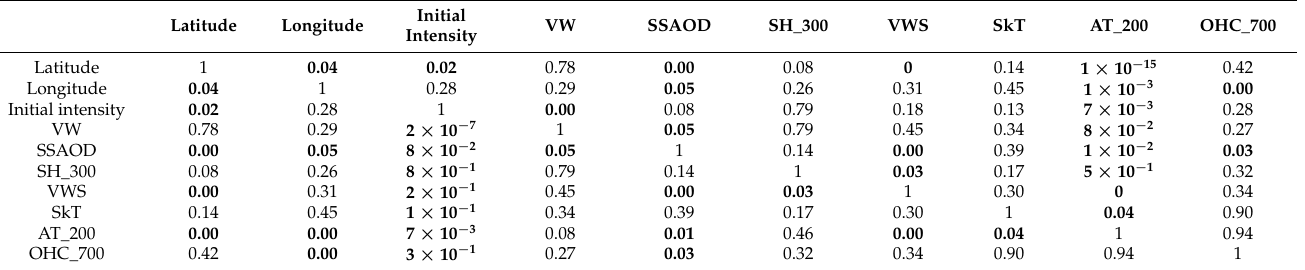
Table 4. Correlation matrix shows p -values between variables at 24 h before SWPO island landfall. Significant relationships at 0.05 level are shown in